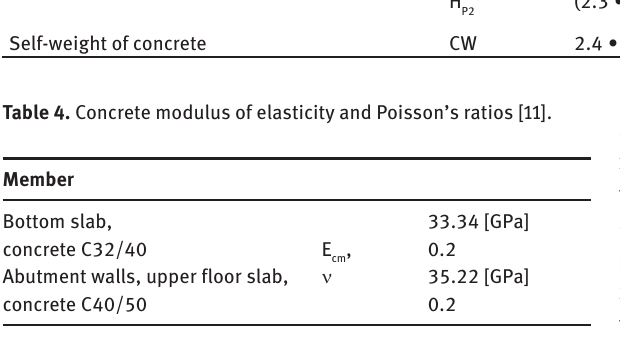
Table 5. Model and parameters analyzed.